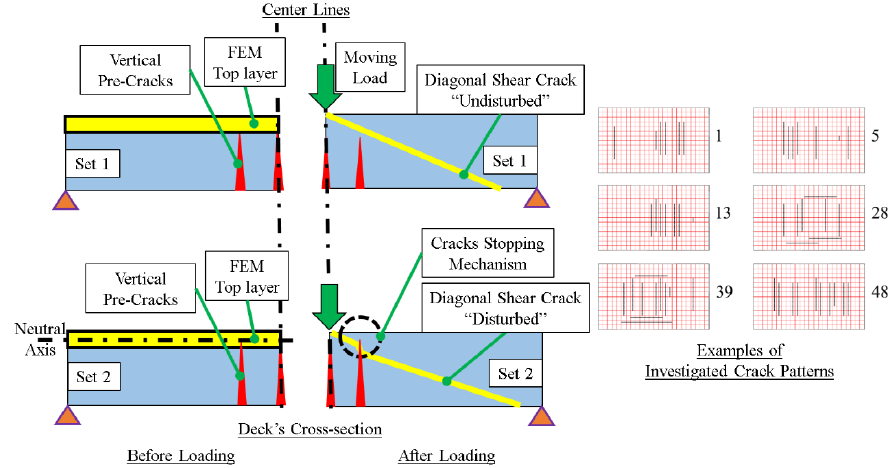
Figure 5. Cracks depth for sets 1 & 2 and pre-cracks stopping mechanism.